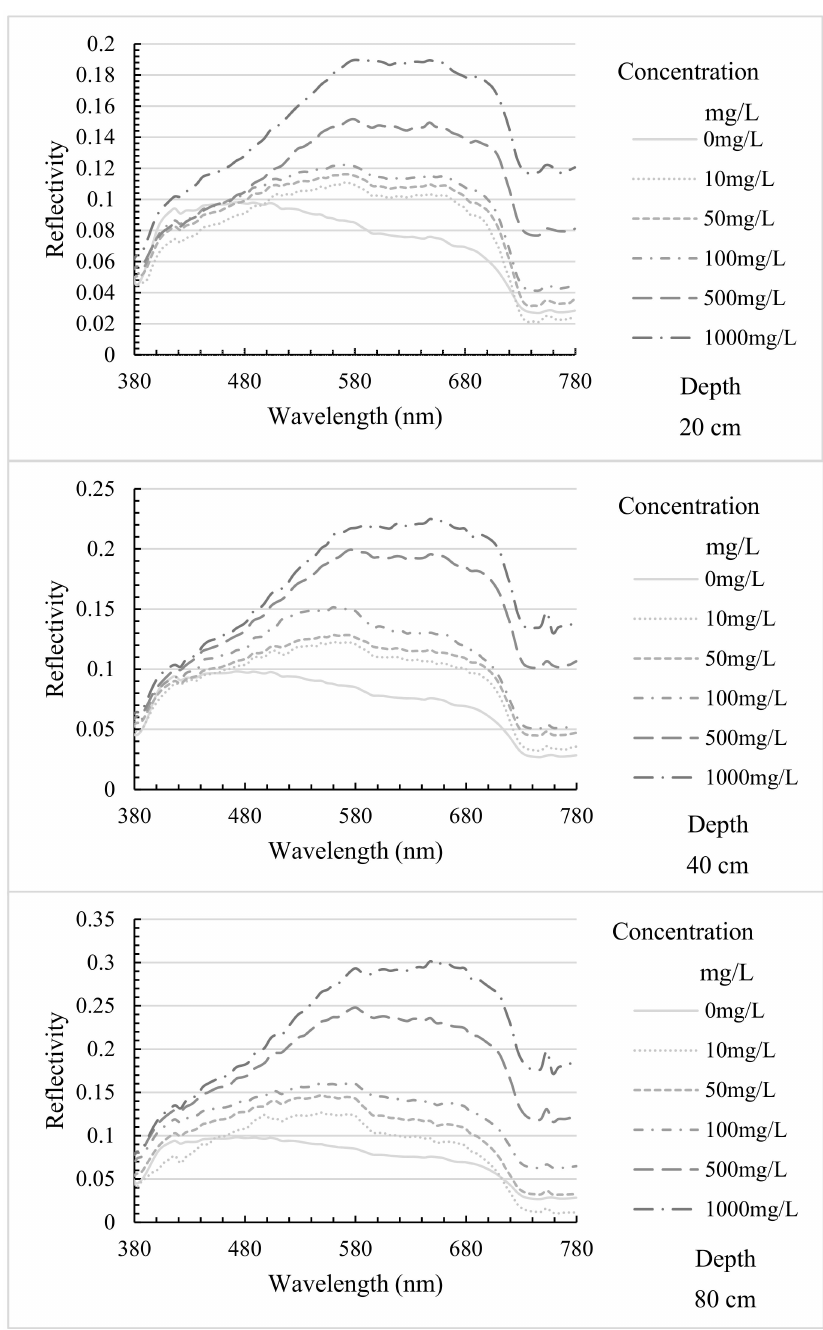
Figure 4. Reflectivity curves of different experimental depths for different sediment concentrations. Depth is the change of water depth. Concentration is the change of sediment concentration. Wavelength is wavelength variation of visible